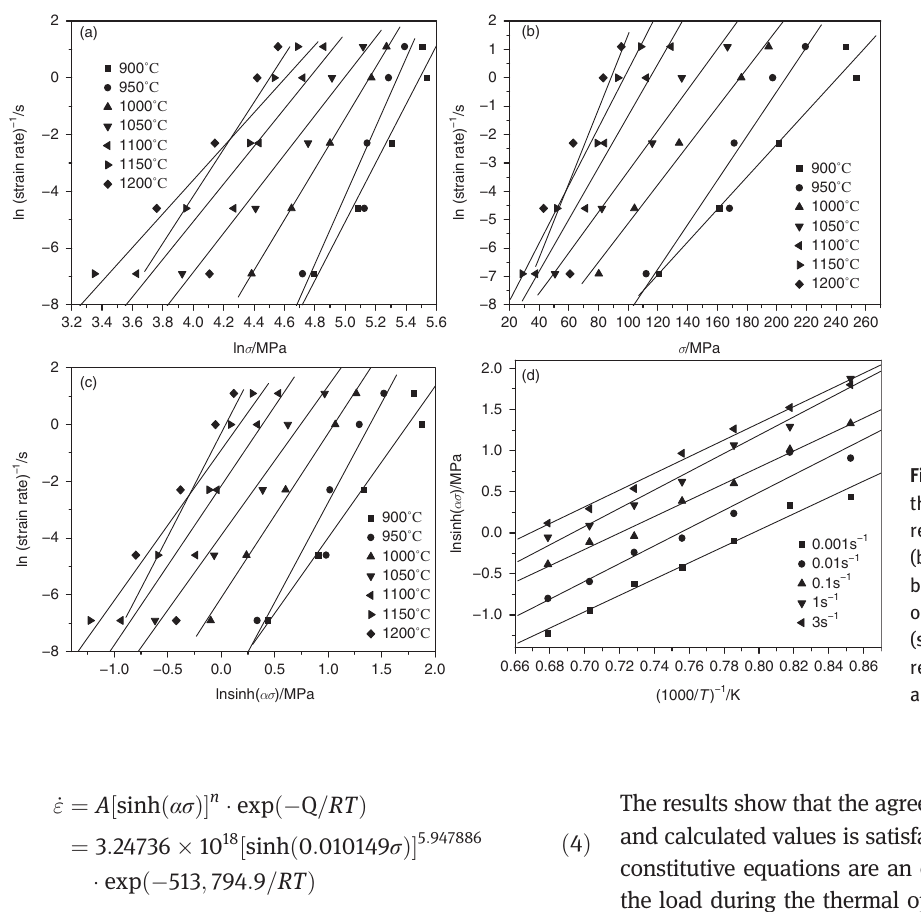
A set of constitutive equations for A100 steel was pro- posed by using an Arrhenius-type equation. The fitted equations for the constants are functions of strain, as shown in eq. (5).